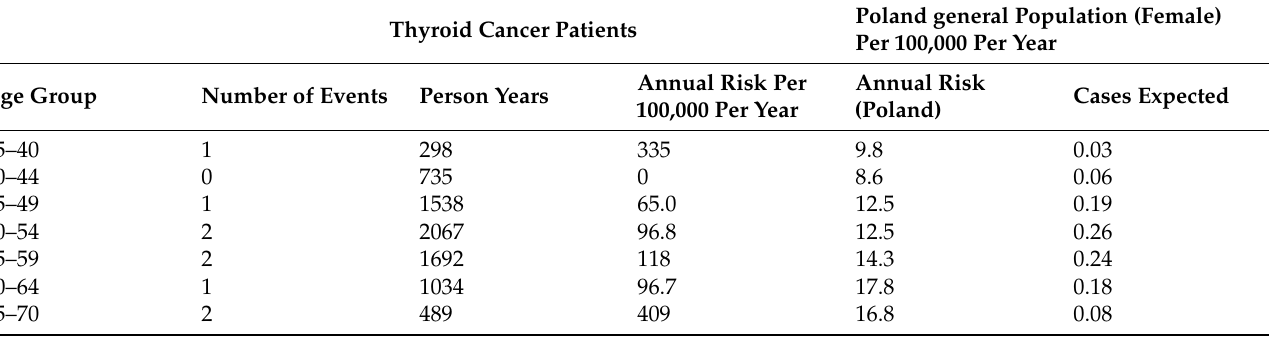
Table 3. Annual rates of thyroid cancer, CHEK2 carriers